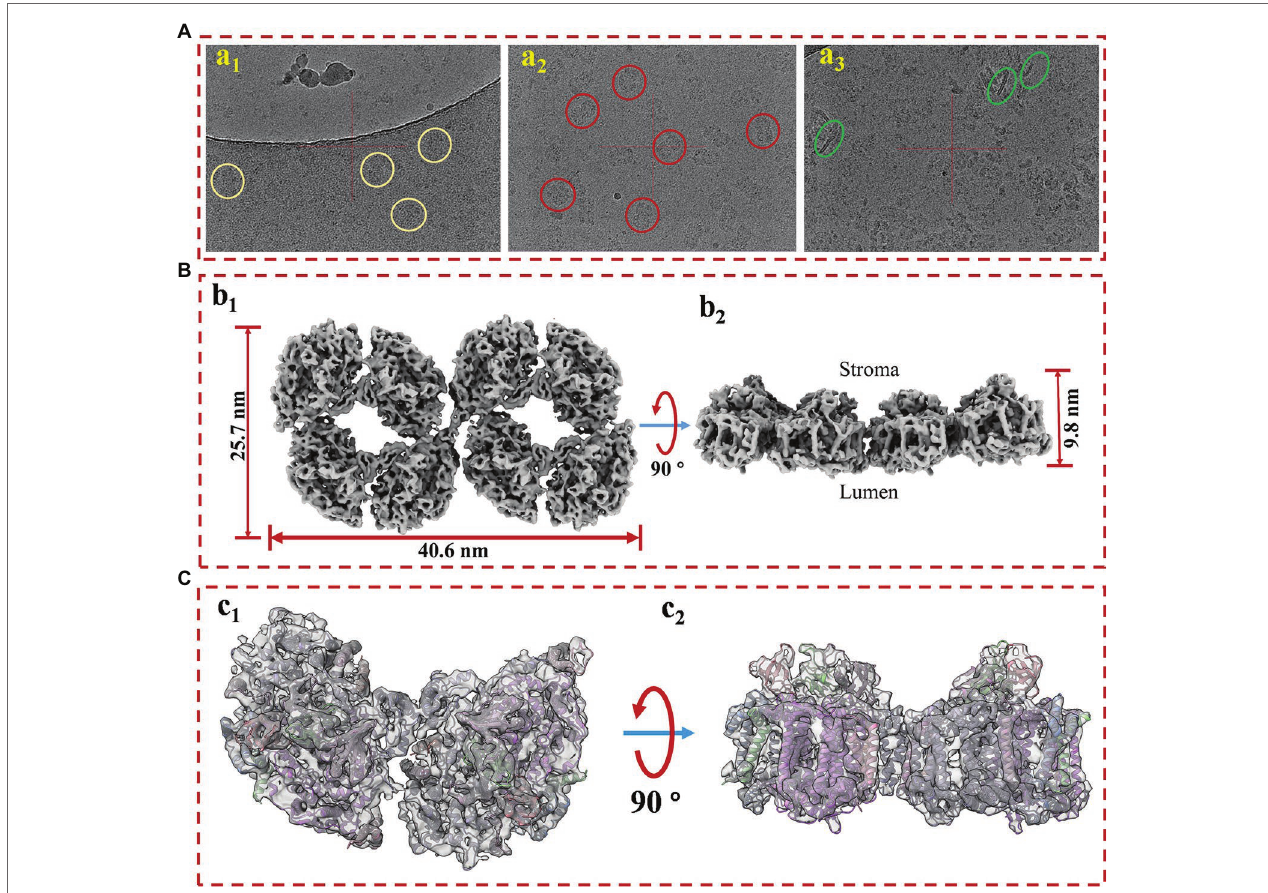
FIGURE 2 | The cryo-EM sample prep optimization and structure determination of PSI supercomplex 2. (A) Optimization of cryo-EM sample. (a 1 ) The protein particles were blotted immediately after sample loading; (a 2 ) detergent fos-coline-8 was supplemented into the protein sample at a final concentration of 1.0 mM around 5 s before blotting; (a 3 ) additional 3 s of waiting time were introduced between the loading and blotting of fos-choline-8 mixed sample. (B) Top (b 1 ) and side (b 2 ) views of the refined 3D density map of PSI supercomplex 2. (C) Model and map fitting for structure comparison of cyanobacterial PSI dimer and the supercomplex. Top (c 1 ) and side (c 2 ) views of model fitting of PSI dimer into the density map. The model used for fitting is a published PSI dimer structure (PDB code: 6K61) from Anabaena sp. PCC